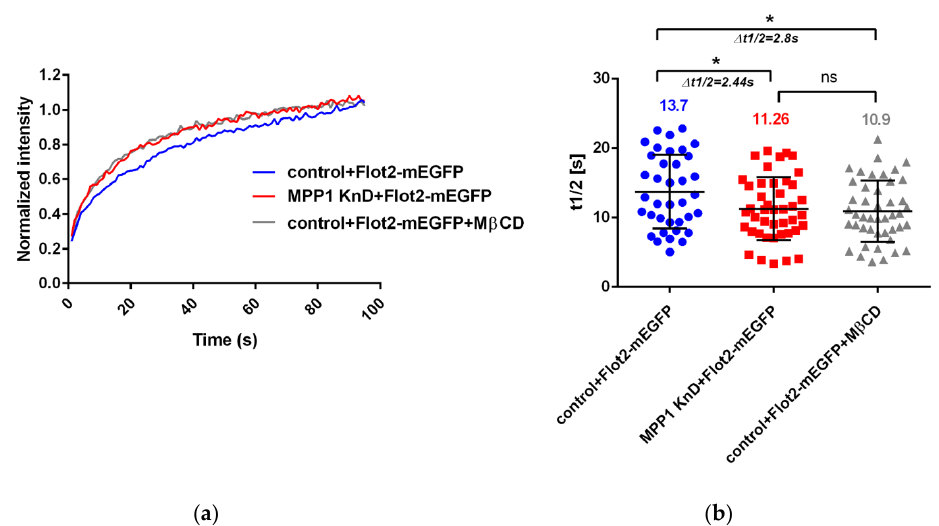
Figure 2. MPP1 limits the lateral mobility of flotillins at the PM. FRAP measurements showing ( a ) normalized average fluorescence recovery curve and ( b ) half-recovery time (t 1/2 ) of the overexpressed Flot2-mEGFP in control (n = 37), MPP1 KnD cells (n = 43) and raft-disrupted MßCD-treated control cells (n = 45). Data represent three independent experiments. Statistical analysis was performed using non-parametric t -test p < 0.05 (*), error bars correspond to the